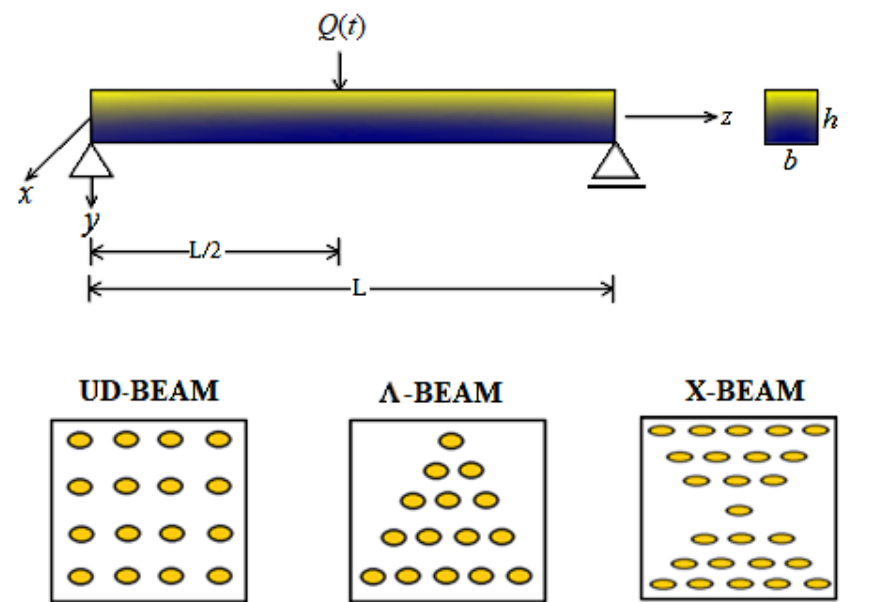
Figure 1. A schematic illustration of a simply supported carbon nanotube-reinforced composite (CNTRC) beam under a harmonic load and three different patterns of CNTs.